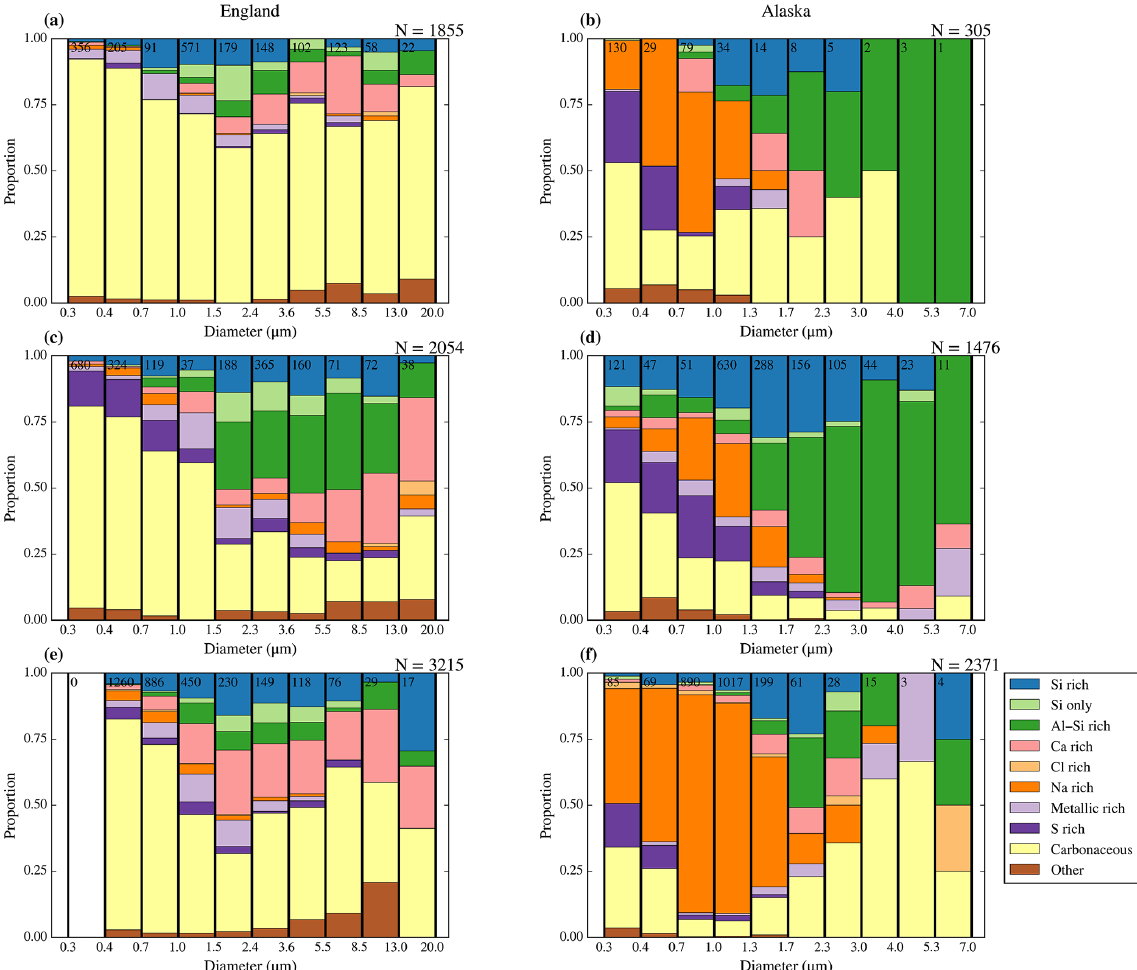
Figure 11. Six examples of the size-resolved composition of aerosol sampled from the BAe-146 aircraft above south England (a, c, e) and northern Alaska (b, d, f) . All the samples were taken with the bypass open. The dates and sampling times (UTC) are (a) 17 July 2017 (flight C022) from 09:29 to 09:41, sampling a total of 182L at an altitude of about 240m; (b) 18 March 2018 (flight C089) from 19:28 to 19:48, sampling a total of 404 L at an altitude of about 600m; (c) 19 July 2017 (flight C024) from 15:20 to 15:52, sampling a total of 256L at an altitude of about 350m (this sample was taken on the same day as the one shown in Fig. 10); (d) 20 March 2018 (flight C090) from 20:15 to 20:37, sampling a total of 724L at an altitude of about 520m; (e) 20 July 2017 (flight C025) from 12:51 to 13:09, sampling a total of 425L; and (f) 21 March 2018 (flight C091) from 18:27 to 18:56, sampling a total of 1187L at an altitude of about 120m at an altitude of about